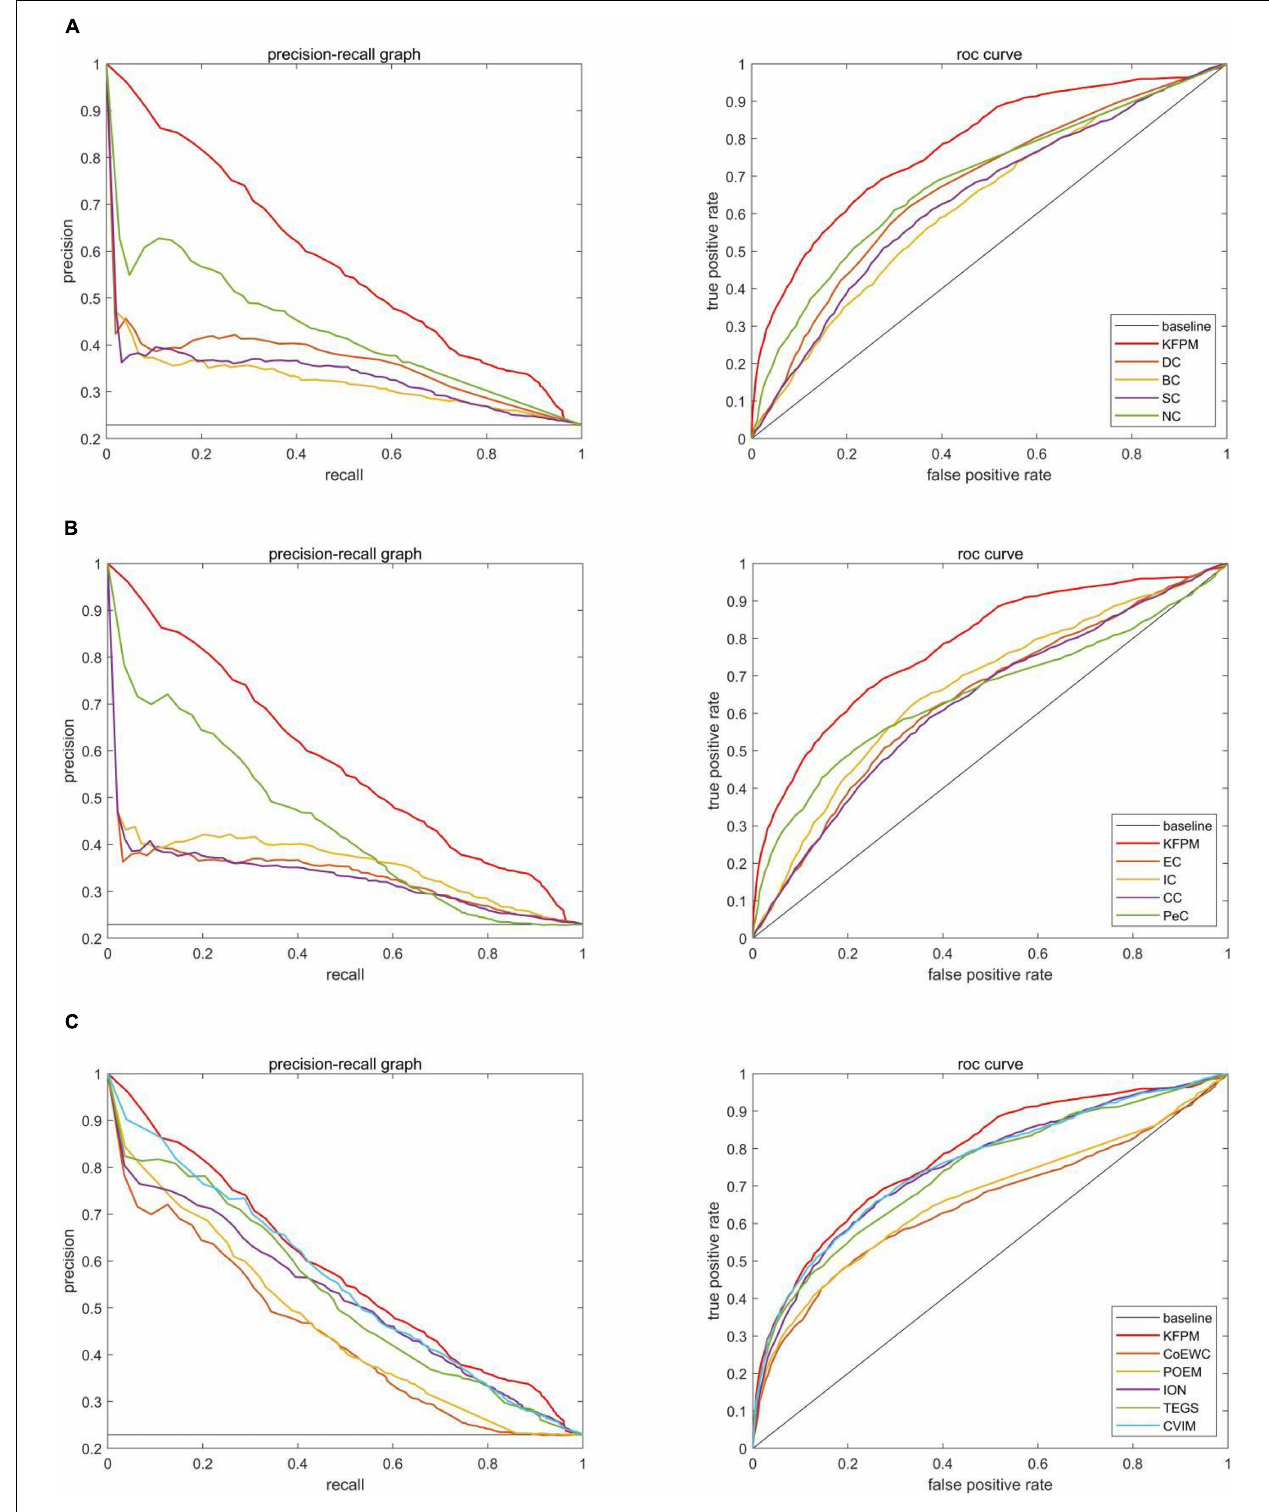
FIGURE 7 | Comparison of PR curves and ROC curves between KFPM and 13 competing methods based on the DIP database. (A) PR curves and the ROC curves of DC, BC, SC, and NC. (B) PR curves and ROC curves of EC, IC, CC and Pec. (C) PR curves and ROC curves of CoEWC, POEM, ION, TEGS, and CVIM.